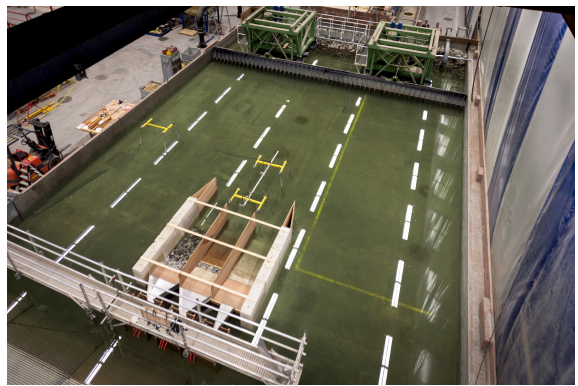
Figure 3. Pacific Basin with